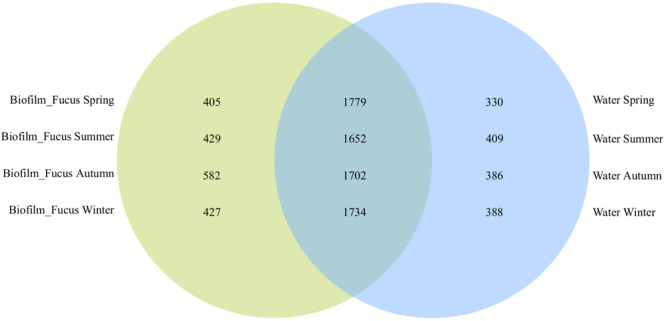
OTU overlaps among biofilm and seawater bacterial communities per season. Venn diagram illustrating the counts of shared OTUs between Fucus vesiculosus biofilm (“Biofilm_Fucus”, green) and seawater (“Water”, blue) bacterial communities during spring, summer, autumn, and winter.